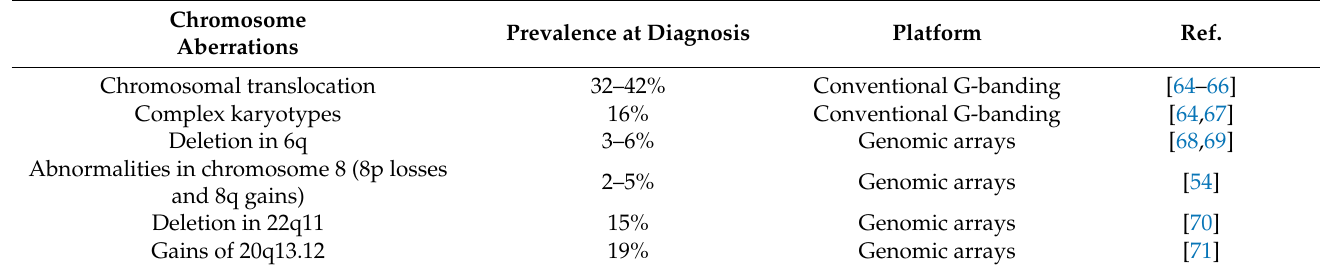
Table 2. The chromosomal abnormalities in CLL patients discovered by various